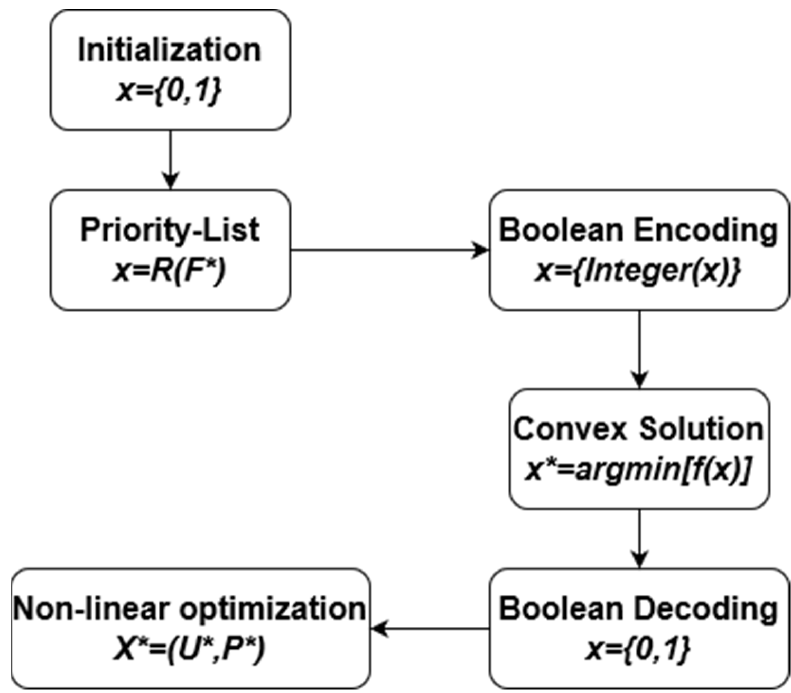
Figure 1. Simplified diagram of the proposed BM solution.